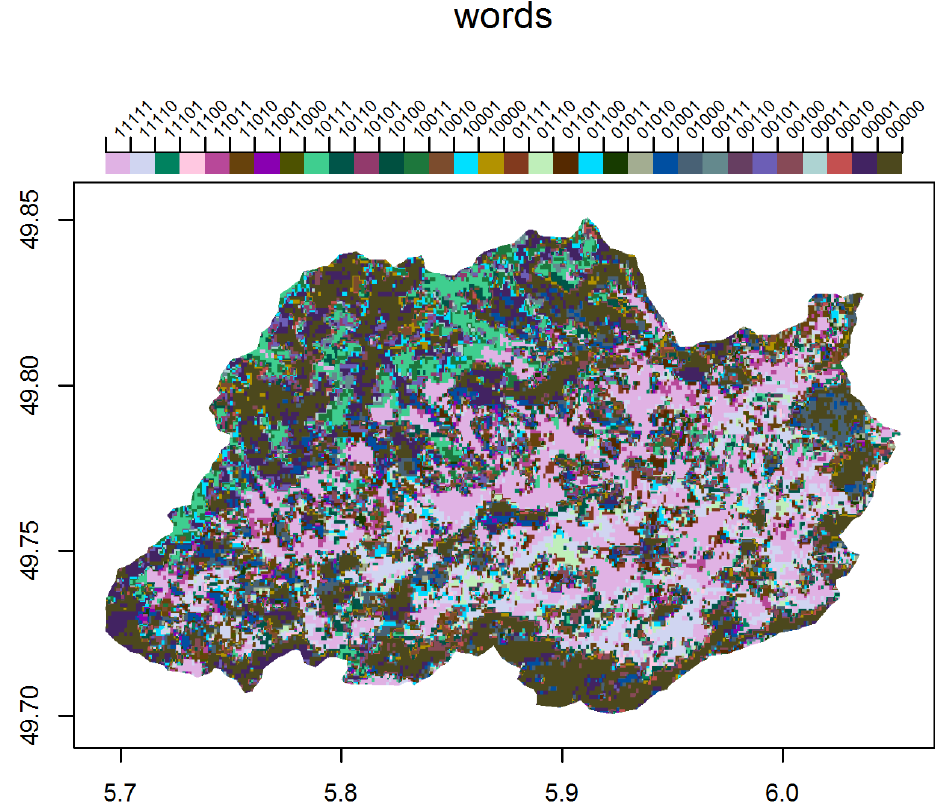
Figure 12. Behavioral classification of the subset LST time series data. The algorithm is producing 2 5 =32 classes of different frequency. The image shows the full bandwidth with classes named in the